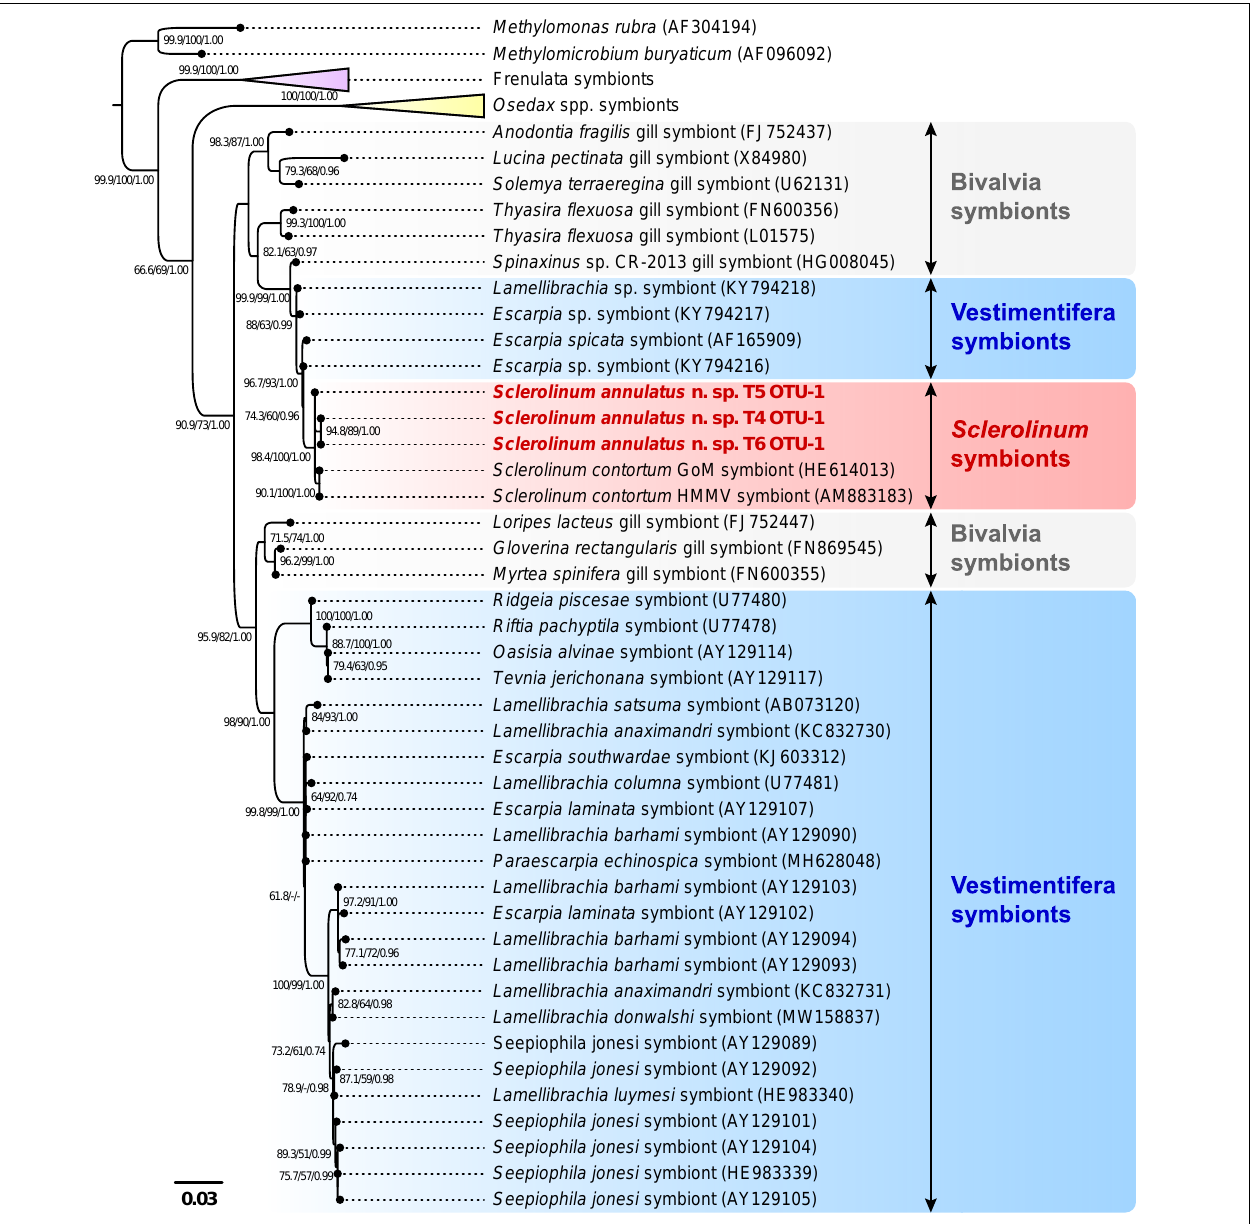
FIGURE 10 | A simplified phylogenetic tree of siboglinid symbionts and their relatives based on the maximum-likelihood (ML) topology inferred from a 1,434-bp gap-containing alignment of the microbial 16S rRNA gene. Bootstrap values from the Shimodaira-Hasegawa-like (SH-like) approximate likelihood ratio tests and the standard non-parametric bootstraps (NB) of the ML analysis, as well as the posterior probabilities from the Bayesian inference (BI) analysis, are shown at nodes (ML-SH/ML-NB/BI). Dashes (-) indicate bootstrap values < 50 or posterior probabilities < 0.70. Scale bar: the number of substitutions per site. GoM, Gulf of Mexico; HMMV, Haakon Mosby Mud Volcano. The full phylogenetic tree refers to Supplementary Figure 1 .